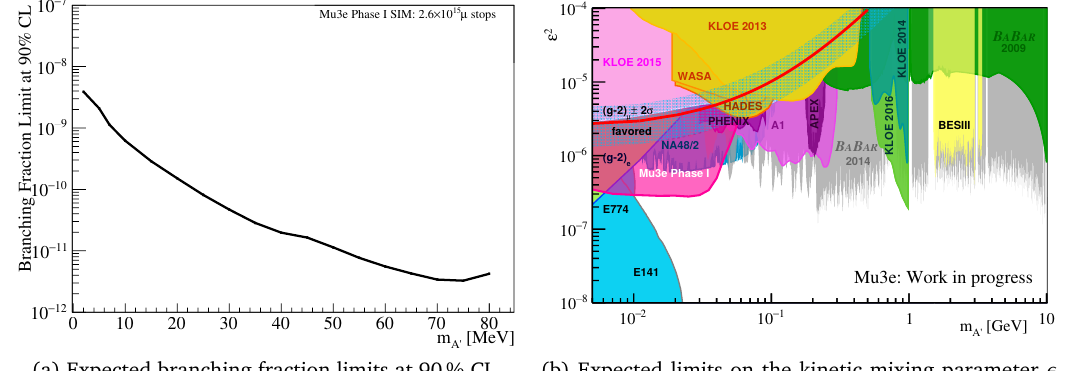
Figure 8: Sensitivity to prompt dark photon decays in µ → eee νν in the phase I Mu3e